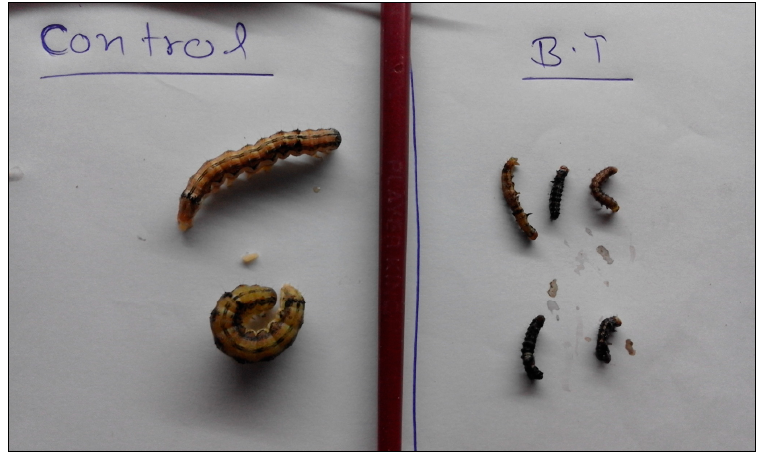
Figure 3. Larvae of H. armigera after feeding on T 3 transgenic and non-transgenic control chick pea plants.